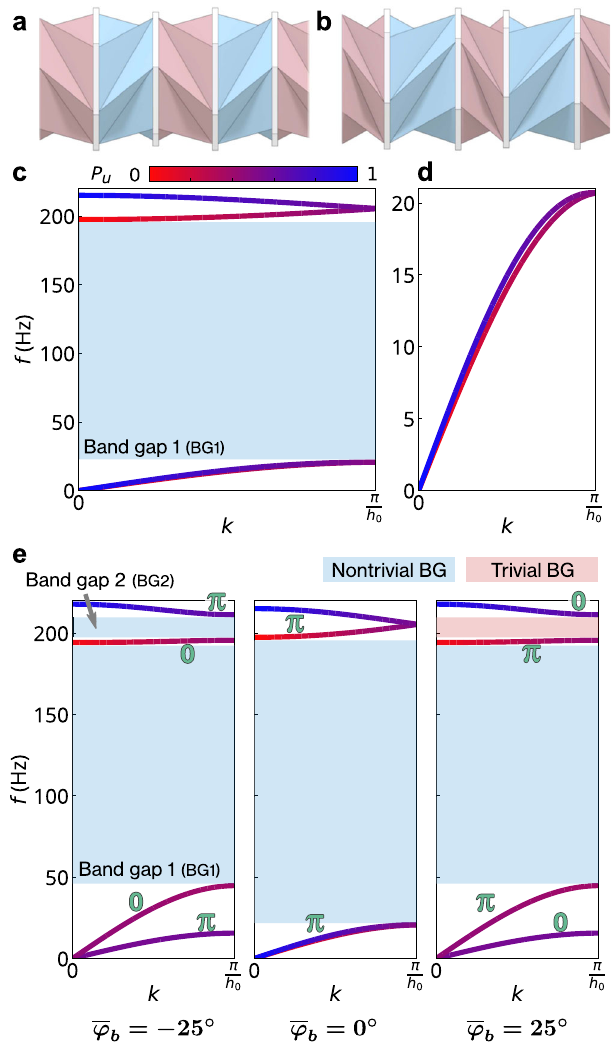
Fig. 2 The dimer Kresling lattices and wave dispersion relationships. The dimer Kresling lattice a under natural condition and b with supercells quasi- statically rotated for 25°. Wave dispersion relationships of the dimer Kresling lattice are also shown. c All four branches are shown with the band gap (BG1) as a blue shaded area. d Enlarged view of the lower two branches. The color map of the solid lines represents the intensity of the axial component described by the polarization factor P ¼ m j u k j 2 þ m j v k j 2 . e The linear wave dispersion relationships for u m j u k j 2 þ m j v k j 2 þ j j φ k j 2 þ j j ϑ k j 2 negatively twisted lattice (left), natural condition (center, reprinted from panel c ), and positively twisted lattice (right). The twist angles for negatively and positively twisted lattices are − 25° and 25°, respectively. The Zak phase for each band is labeled in green. Trivial and nontrivial band gaps are shaded with pale red and pale blue, respectively. The geometrical ¼ 70 (cid:3) and θ ð 2 Þ ¼ (cid:2) 70 (cid:3) parameters are: h 0 = 30 mm, R = 36 mm, θ ð 1 Þ 0 0